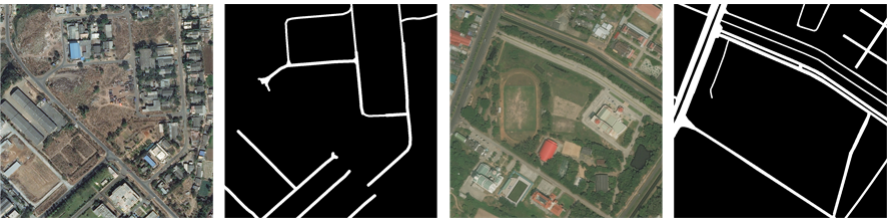
Figure 1. Examples of the original images and coressponding ground truth. The white represents the road pixels and the black represents the non-road pixels.